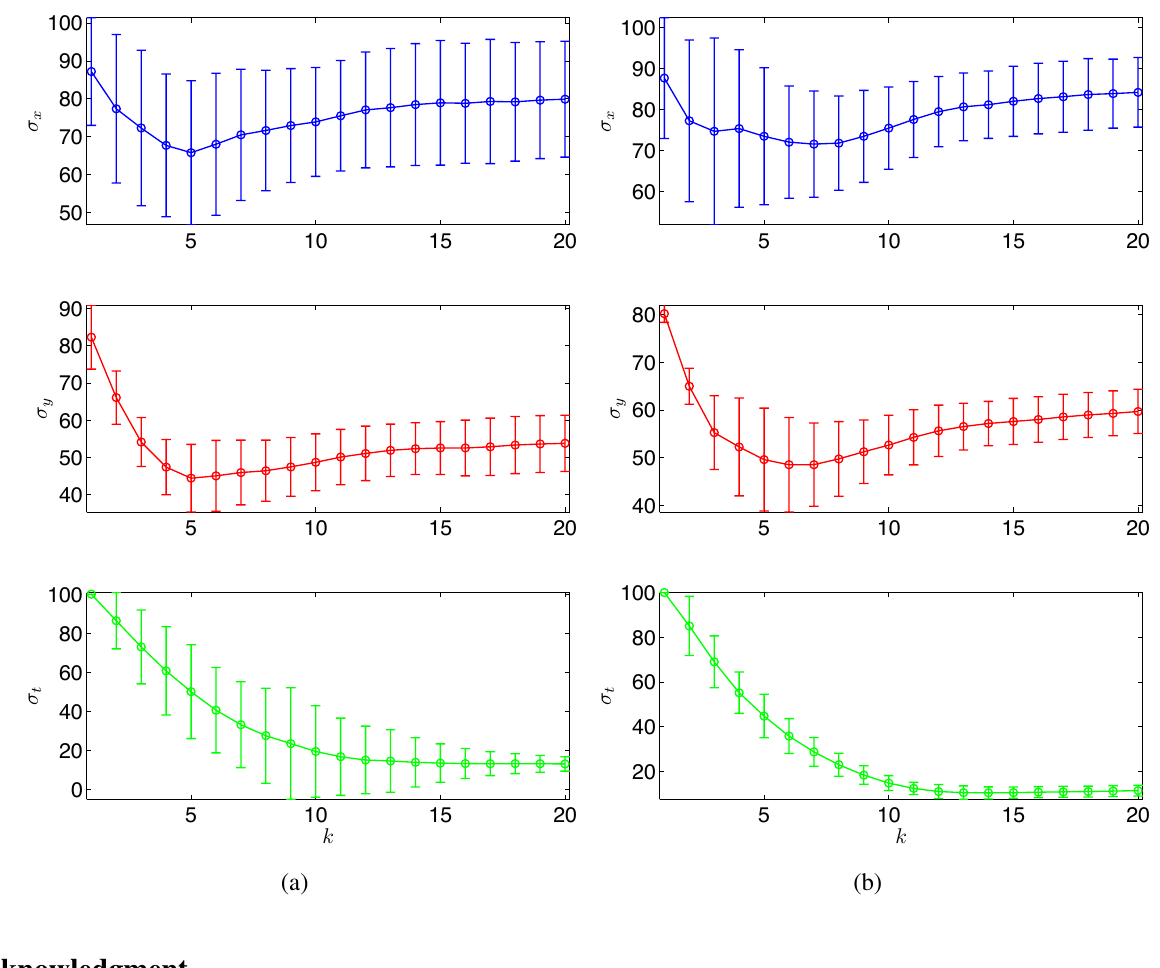
Figure 6. Simulation results (100 runs) for a advection-diffusion process. The estimated hyperparameters with (a) random sampling and (b) optimal sampling.